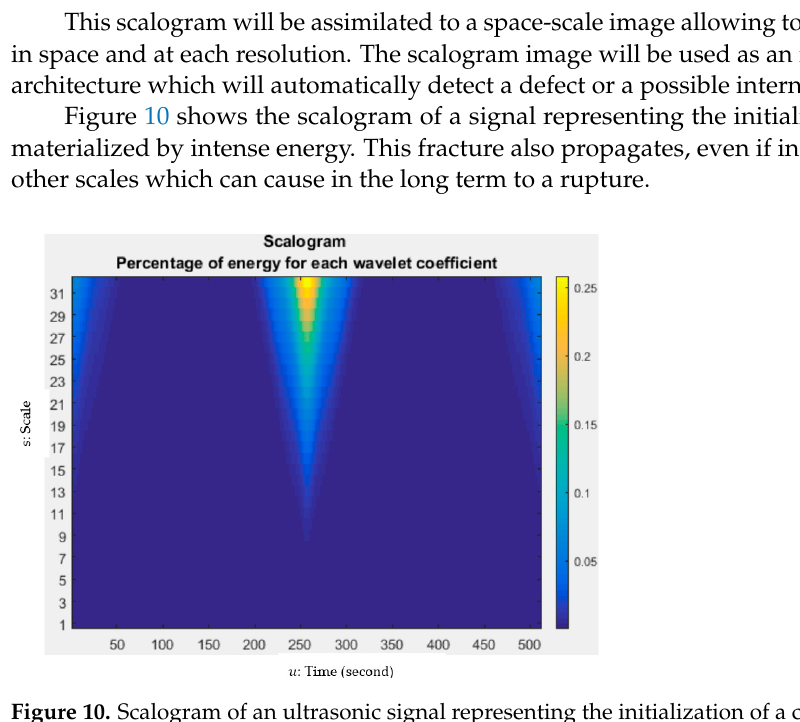
Figure 10. Scalogram of an ultrasonic signal representing the initialization of a crack.